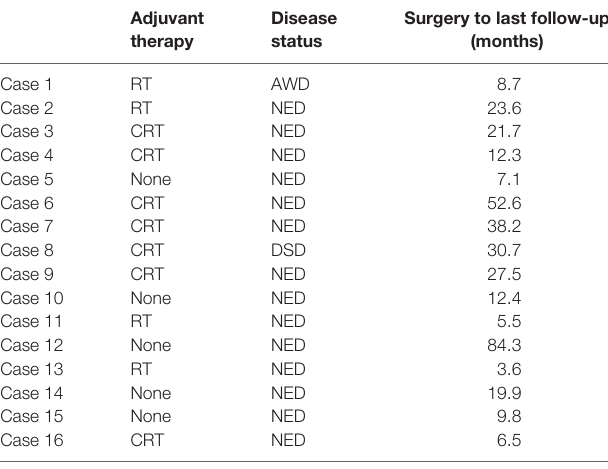
Table 3 | Postoperative care and follow-up.